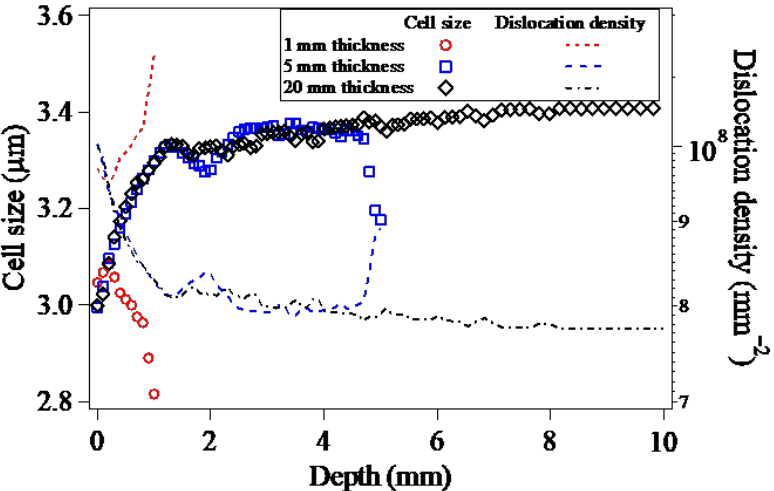
Figure 14. In − depth dislocation densities and cell sizes of the targets with different thicknesses. The three-dimensional finite element models coupling with the infinite elements were developed to simulate the LSP of pure Al, and the dislocation density-based constitutive model was employed to characterize the dynamic mechanical behavior of the LSPed target model. The effect of the dynamic propagation, attenuation and reflection of the LSP- induced shock wave on the resultant plastic deformation, compressive residual stress